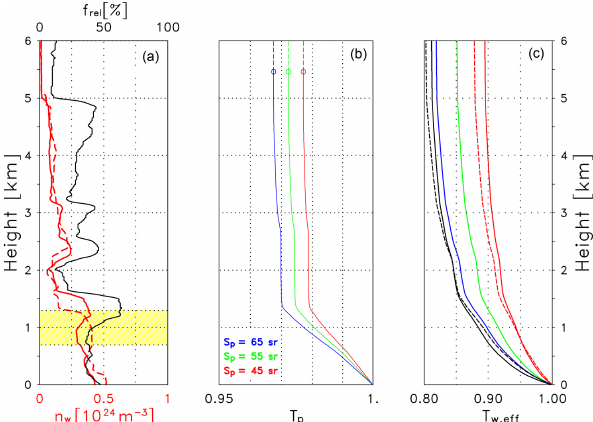
Figure 10. (a) Profile of the relative humidity (black line) in per- cent (see labels at the top) and profiles of the water vapor num- ber density (in 10 24 moleculesm − 3 , labels at the bottom) for the 00:00UTC ascent (solid red line) and the 06:00UTC ascent (dashed red line). The validation range is indicated by the yellow area. (b) Particle transmission T p at 1064 nm derived the from Klett in- version of RALPH signals (2 July 2015, 00:00–03:00UTC, Case A) assuming a lidar ratio as indicated. The circles indicate the refer- ence height. (c) Effective water vapor transmission T w , eff for dif- ferent laser wavelengths λ on . Solid lines: 900nm (black), 905nm (red), 907nm (green), 910nm (blue). Dashed lines: 915nm (black), 925nm